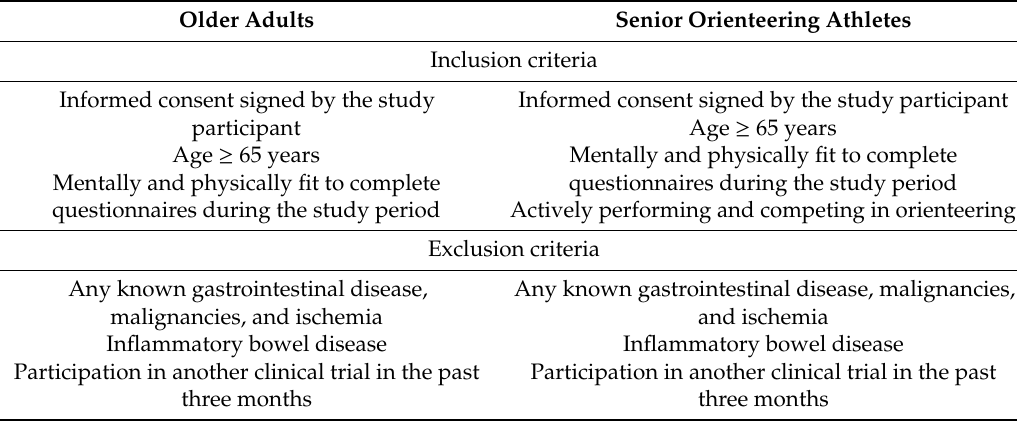
Table 1. Inclusion and exclusion